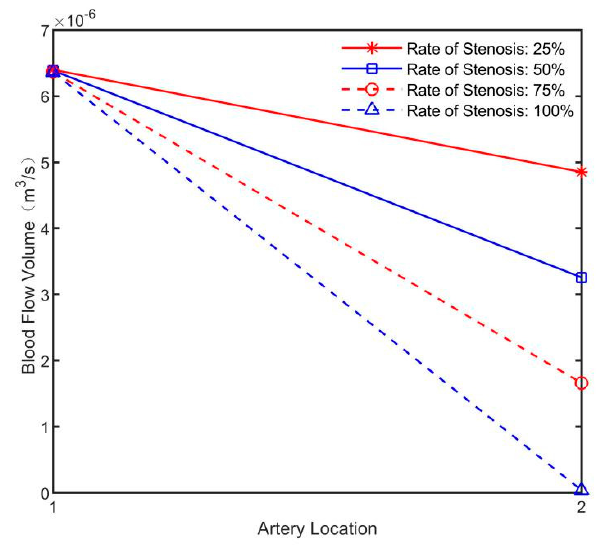
Figure 13. Inverse results of blood flow in arterial models with different rates of stenosis.